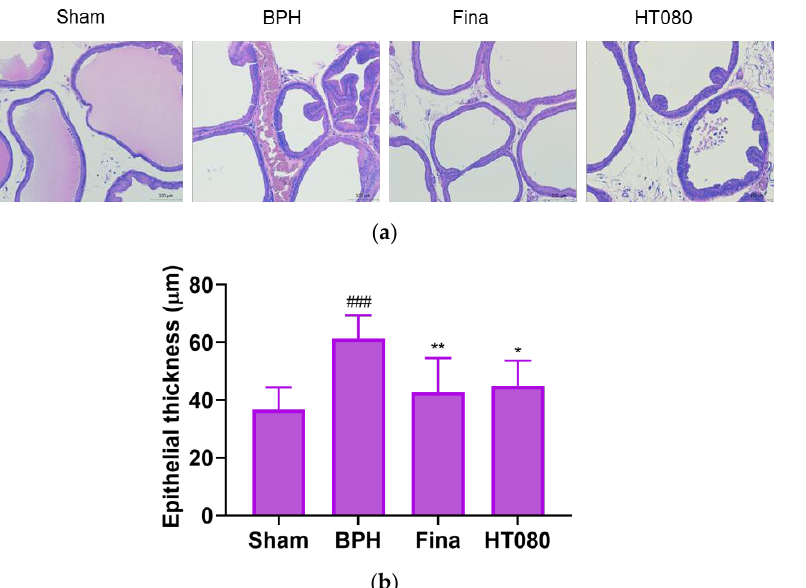
Figure 3. The histopathological analysis of the prostate tissues in testosterone propionate-induced benign prostatic hyperplasia (BPH) rats after being treated with HT080. (a) H&E staining of sham, BPH, finasteride (Fina), and HT080 groups. (b) Quantification of the thickness of epithelial layers. Statistical significance: ### p < 0.001 (compared to sham group using Dunnett’s test); * p < 0.05, ** p < 0.01 (compared to BPH group using Dunnett’s test). Values are expressed as the mean ± S.D.